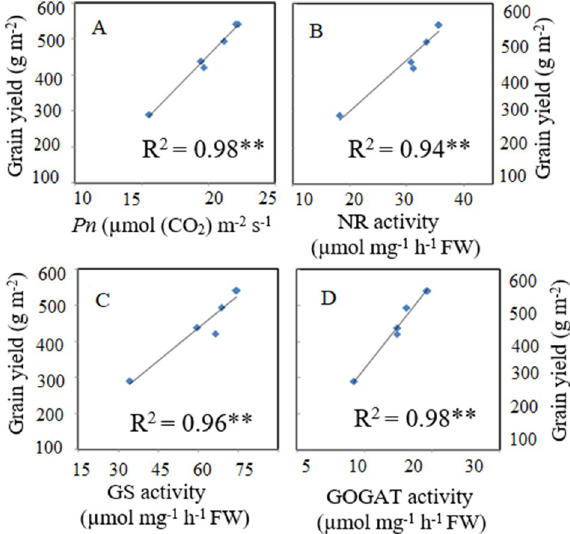
Figure 5. Linear relationships of grain yield with net photosynthetic rate ( Pn ) ( A ), Nitrate reductase (NR) ( B ), glutamine synthetase (GS) ( C ), and glutamine oxoglutarate aminotransferase (GOGAT) ( D ). ** p < 0.01. n = 6.